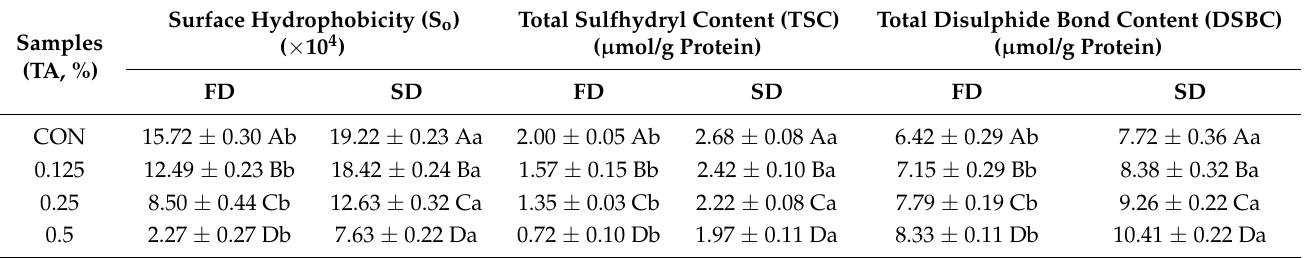
Table 1. Surface hydrophobicity, total sulfhydryl, and disulfide bond contents of freeze-dried (FD) and spray-dried (SD) fish myofibrillar proteins (FMP) modified with tannic acid (TA) at varying